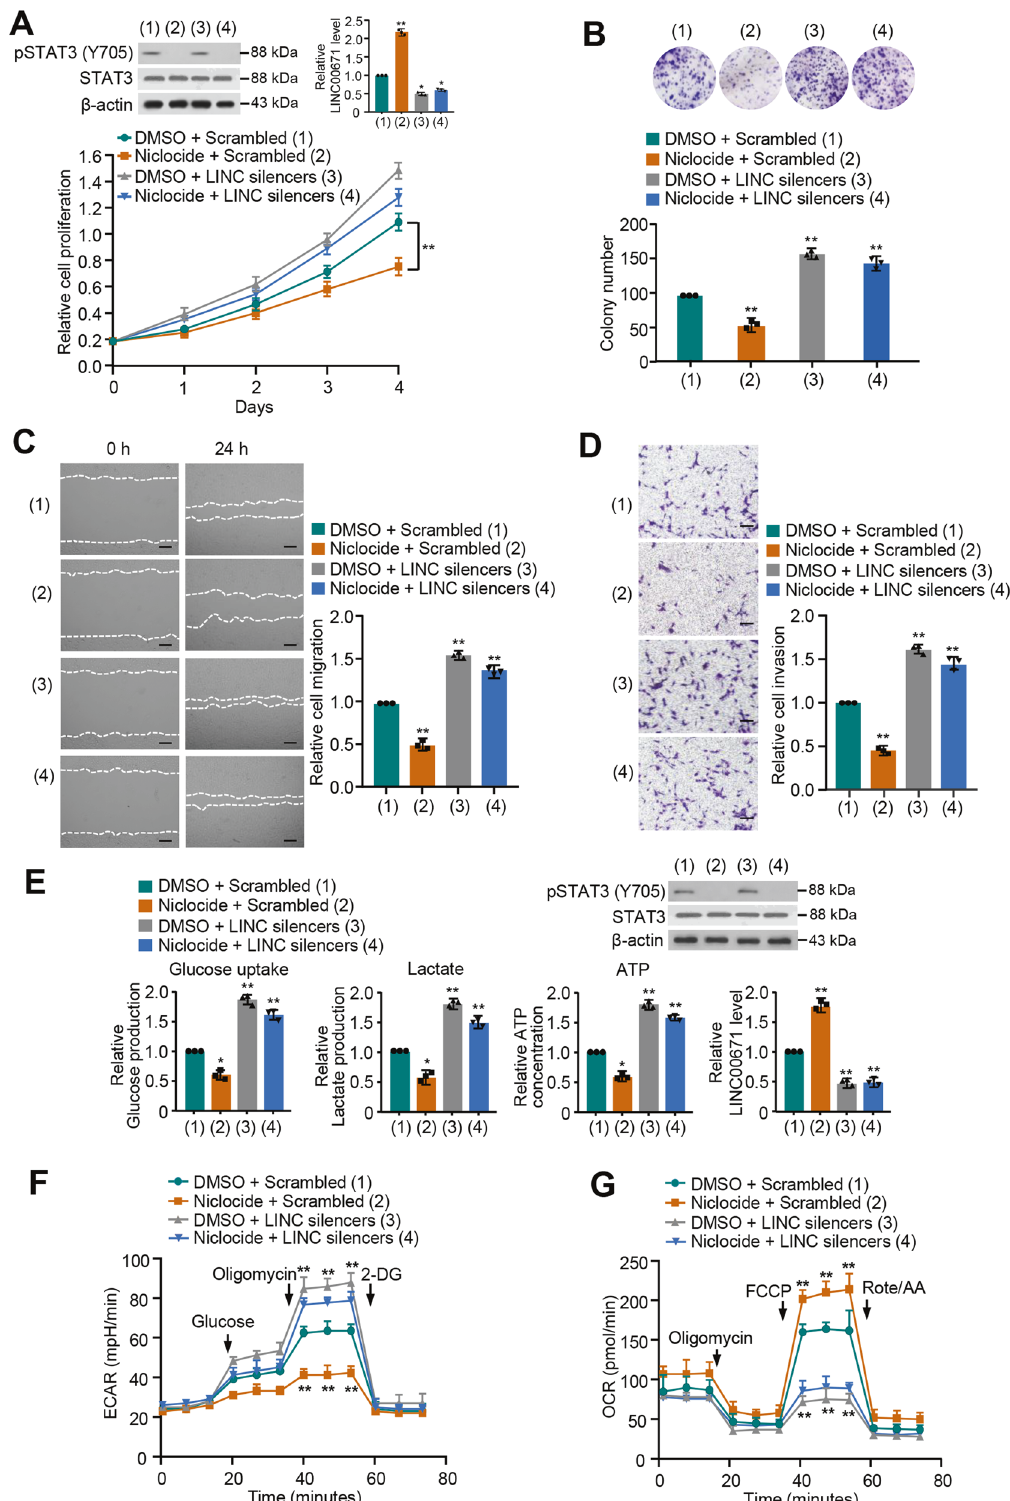
LDHA, as one of the key glycolytic enzyme, catalyzes the reduction of pyruvate to lactate acid by compensating for the decreased function of oxidized mitochondria and maintains cell survival under hypoxic conditions [23, 24]. The aberrant expression and upregulation of LDHA are closely related to a variety of